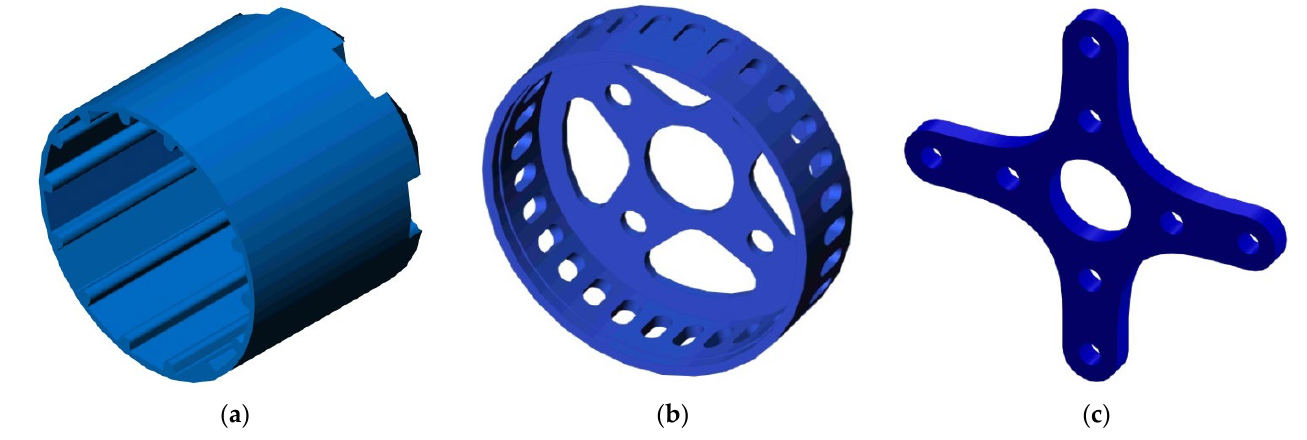
Figure 1. Designed components of BLDC motor: ( a ) rotor; ( b ) left case; ( c ) motor mount.